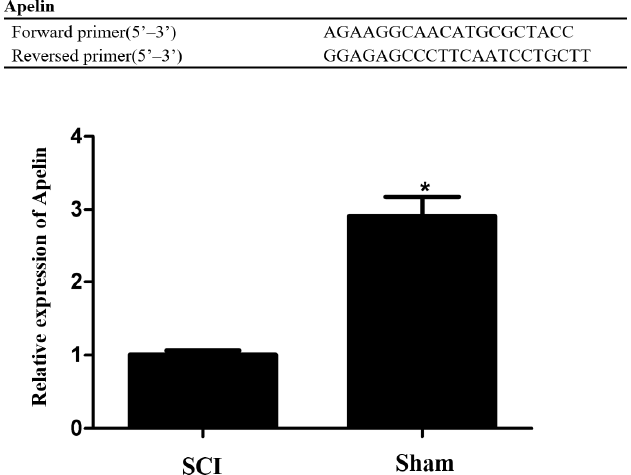
Figure 1. Primer sequences of Apelin and qRT-PCR results showed that the expression of Apelin in spinal cord injury tissues was down-regulated compared with normal rat spinal cord tissues. * p < 0.05.